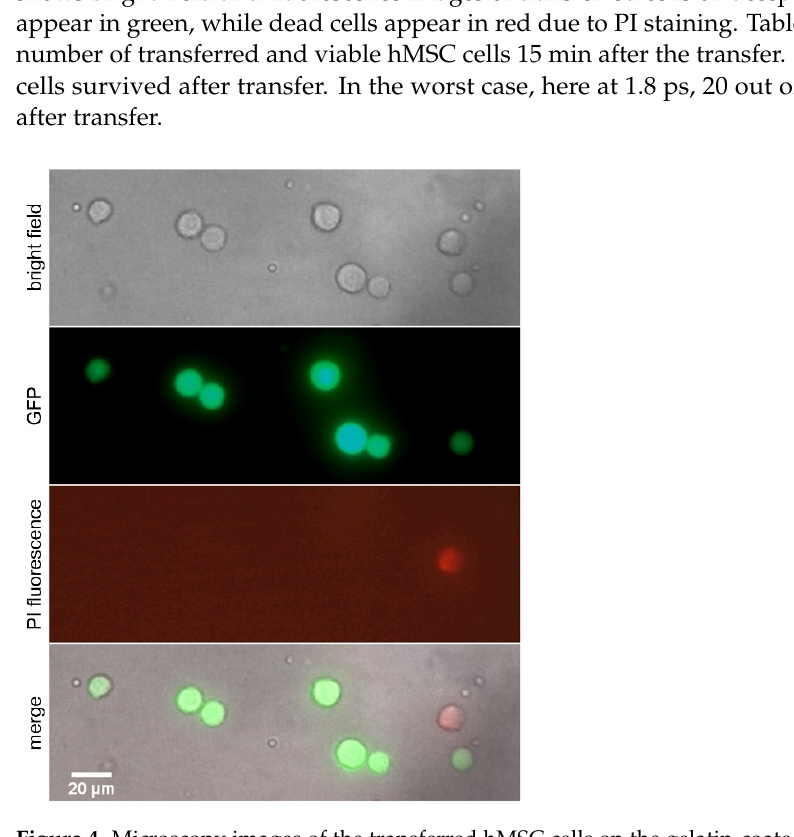
Table 1. Jet width and velocity of the jets in dependency of the laser pulse duration. Obtained kinetic energy for the jet propagation and corresponding energy conversion efficiency.